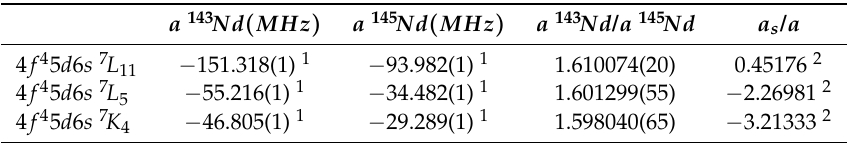
Table 1. Hyperfine interaction constants in Nd.